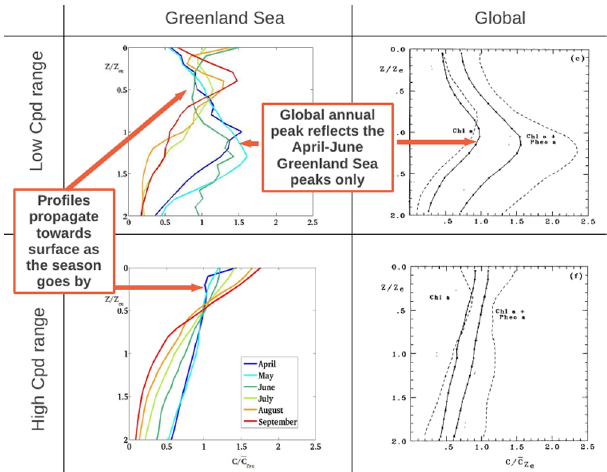
Fig. 7. Dimensionless chlorophyll profiles categorized according to their chlorophyll within the surface layer ( C pd ) . Two C pd ranges out of seven computed are shown. Vertical axis shows depth di- vided by the euphotic layer depth ( Z eu ). Horizontal axis shows chlorophyll divided by the mean chlorophyll for Z eu . Left: Green- land Sea monthly mean profiles computed in this study. Right: from global relationship (Morel and Berthon (1989), copyright (1989) by the Association for the Sciences of Limnology and Oceanogra- phy, Inc.), we are interested in the solid line marked CHL a (mean chlorophyll profile). Top is low C pd range (0.15 <C pd < 0.30); bot- tom is high C pd range (1.5 <C pd <